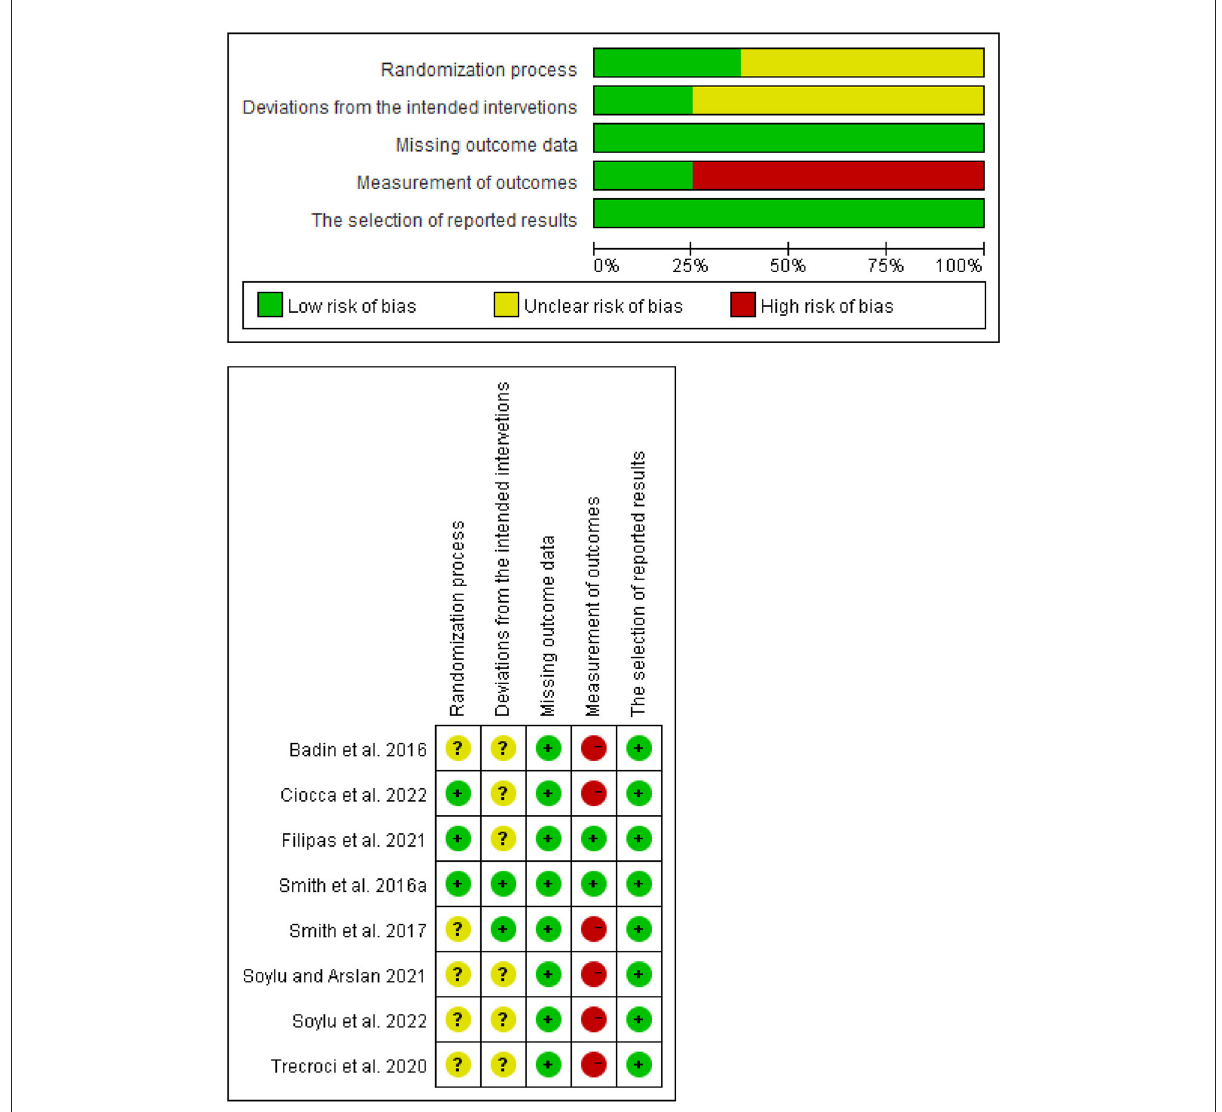
FIGURE2 Risk of bias assessment using Rob 2 for included studies.